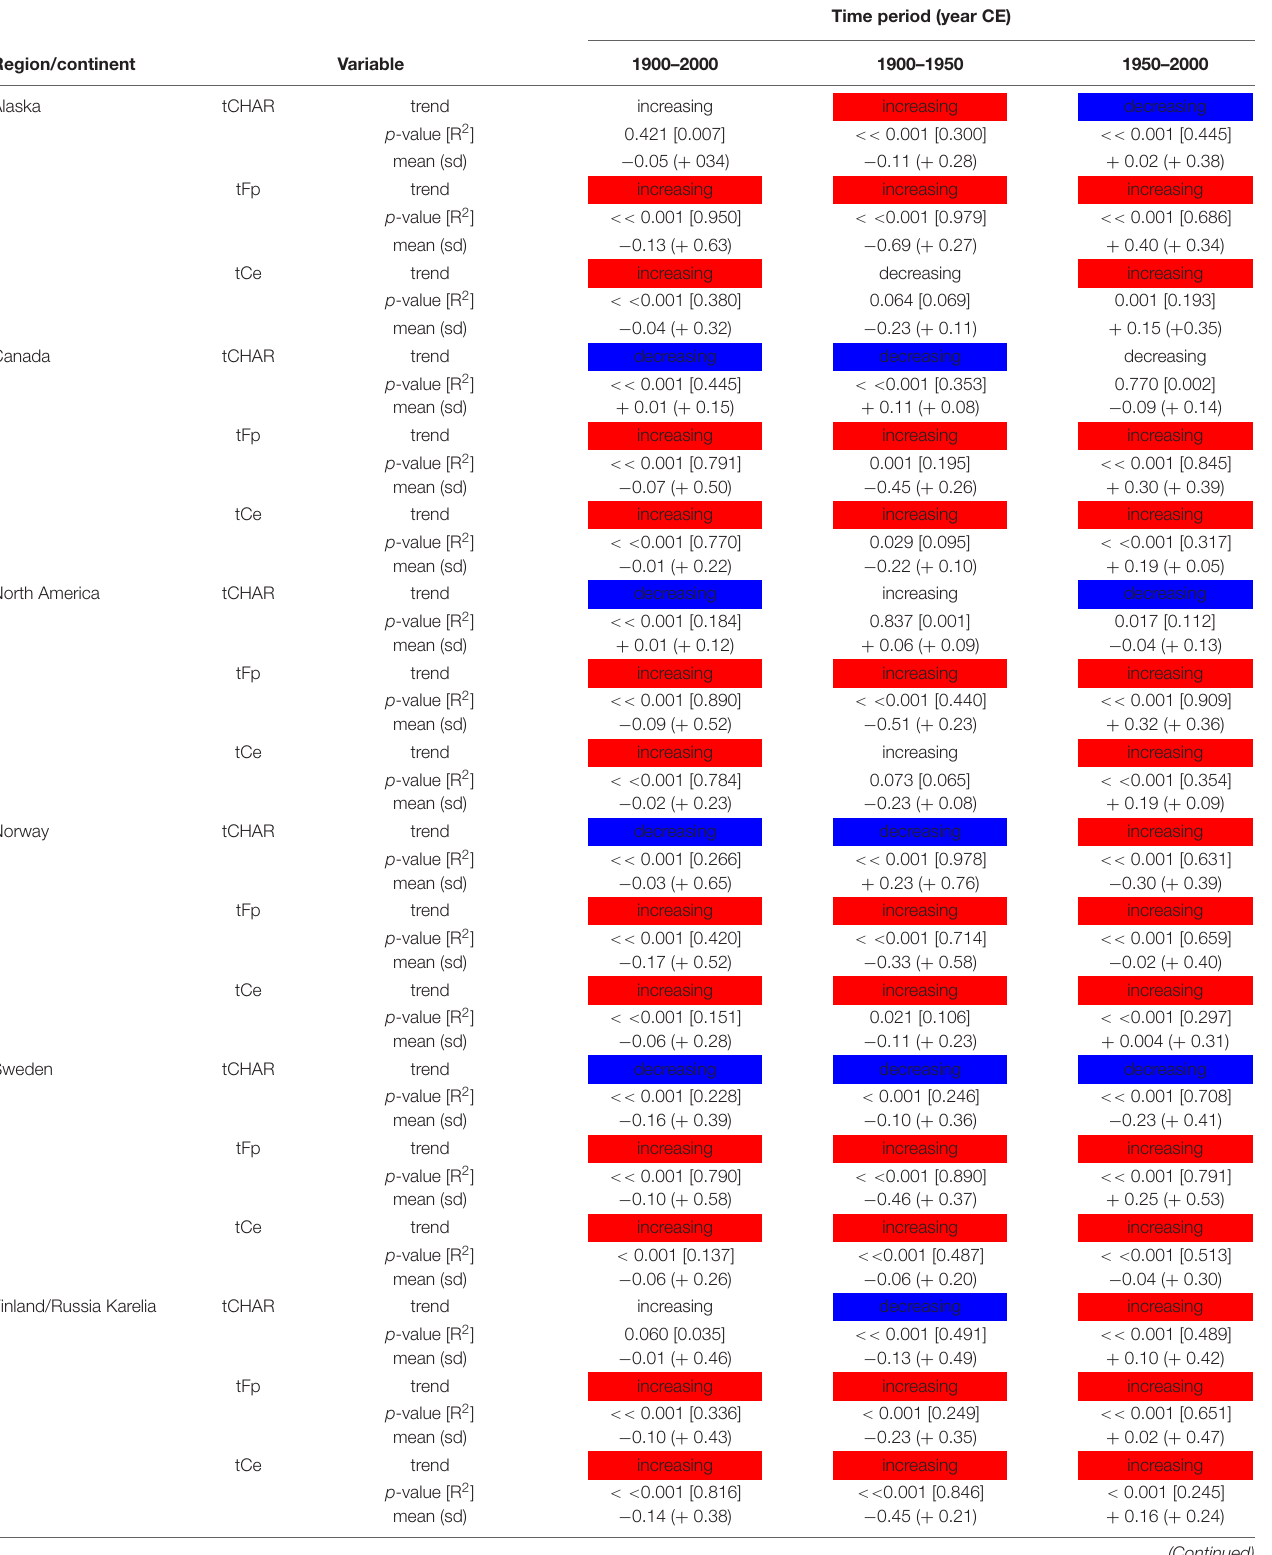
TABLE 2 | Trends of fire activity in boreal forests for the 20 th century expressed by mean (standard deviation, sd) Z-score of transformed charcoal influx (tCHAR), mean (standard deviation, sd) Z-score of transformed fire probability (tFp) and mean (standard deviation, sd) Z-score of carbon emitted